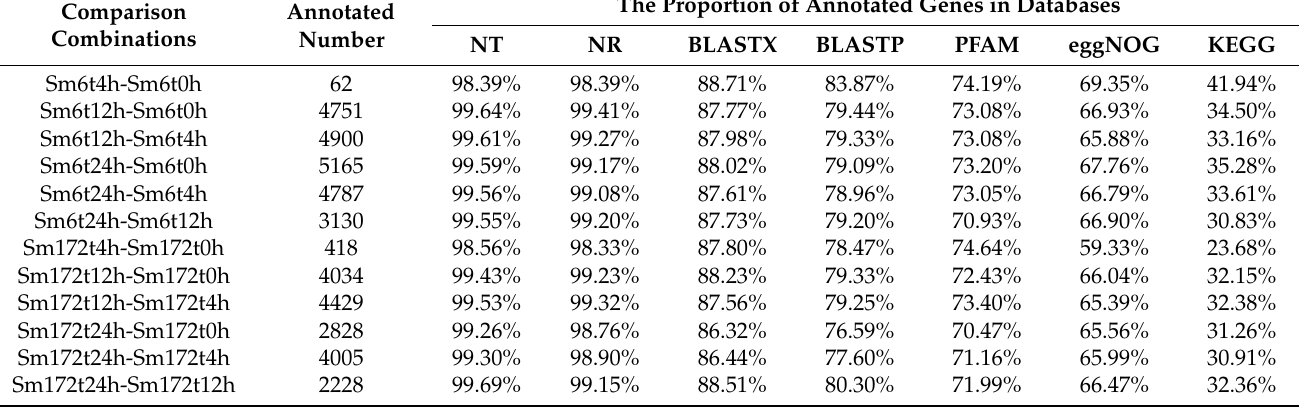
Table 8. Gene annotations in databases.